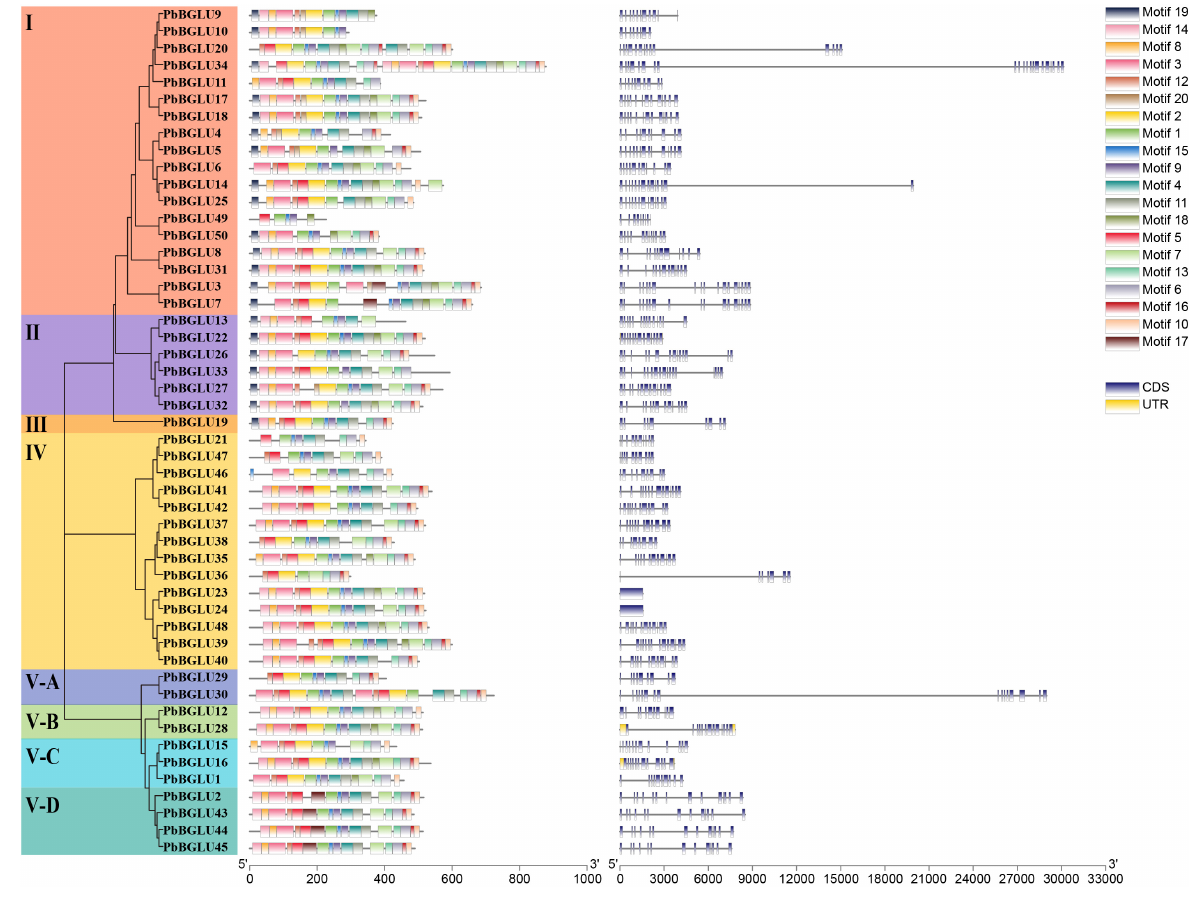
FIGURE 1 | Phylogeny, conserved motifs and exon-intron structure of BGLU genes in pear. MEME tools were used to identify motifs. Different colors represent different motifs. GSDS online website was used to generate structure. The legend is located at the bottom right of the figure. Scale represents the length of the DNA